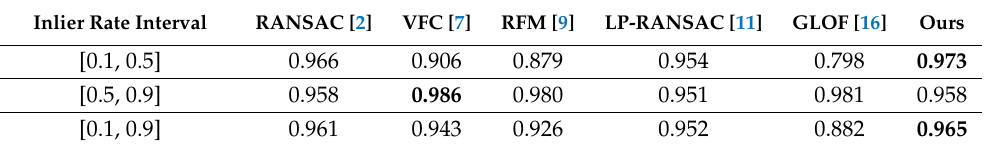
Table 3. Average F1-score comparison for the “University Campus”